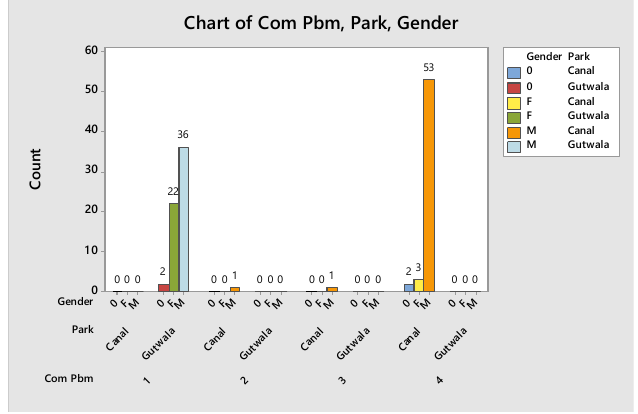
Figure 14: Bar Chart of Blood Pressure problem between both sites 5 males out of 60 visitors responded highly affected by the Blood Pressure due to noise pollution depicted in fig.13 while 3 out 60 showed mild and 1out of 60 showed low response out of 60 did not show any response in the site-1 Canal Park, contrarily, all sampled 60 except 1 visitors including both male and female in the Site-2 Gat Wala Park did not show any symptom of Blood Pressure due to noise pollution, Results showed that mostly observed response in this regard was nil.